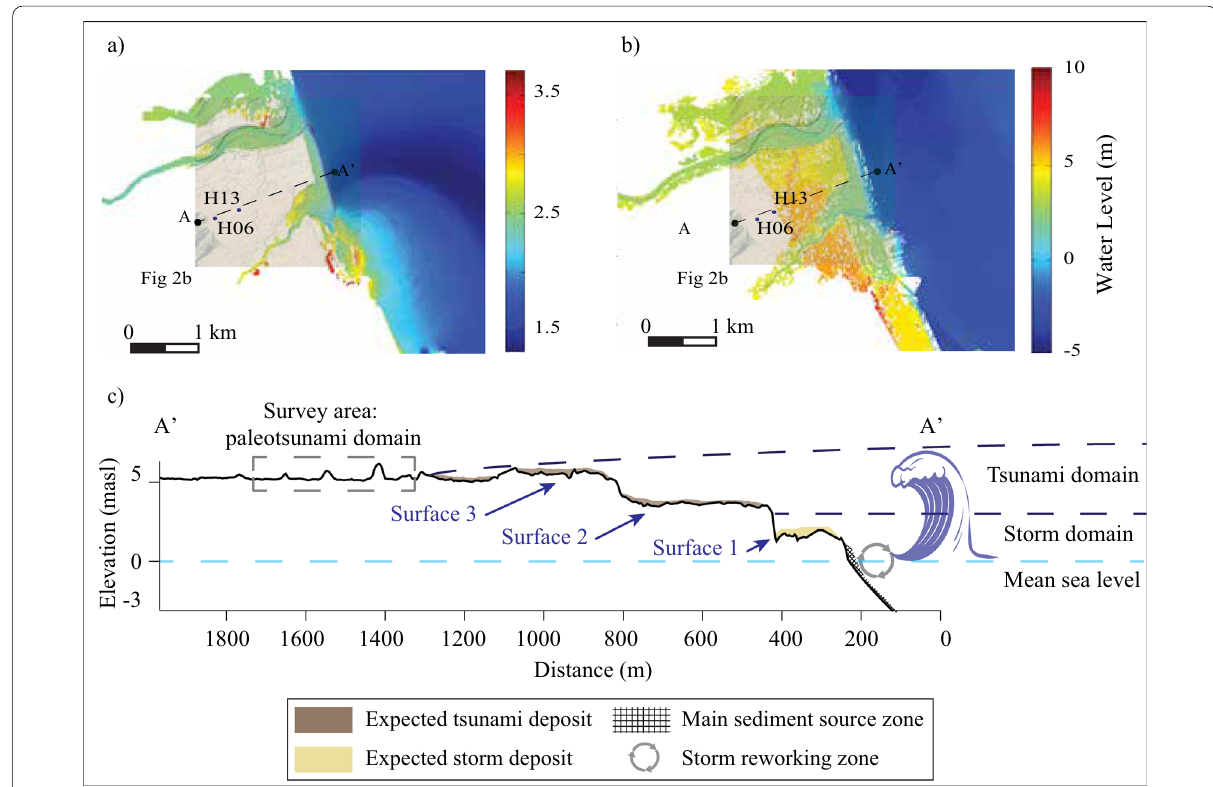
Fig. 2 Maximum calculated inundation areas for storm and tsunami events for the survey site (modified after Velasco et al., 2019). The calculation area corresponds to the area of Fig. 1b. a Maximum calculated inundation by storm surge. b Maximum calculated inundation by tsunami surge. c Schematic model comparing storm and tsunami inundation